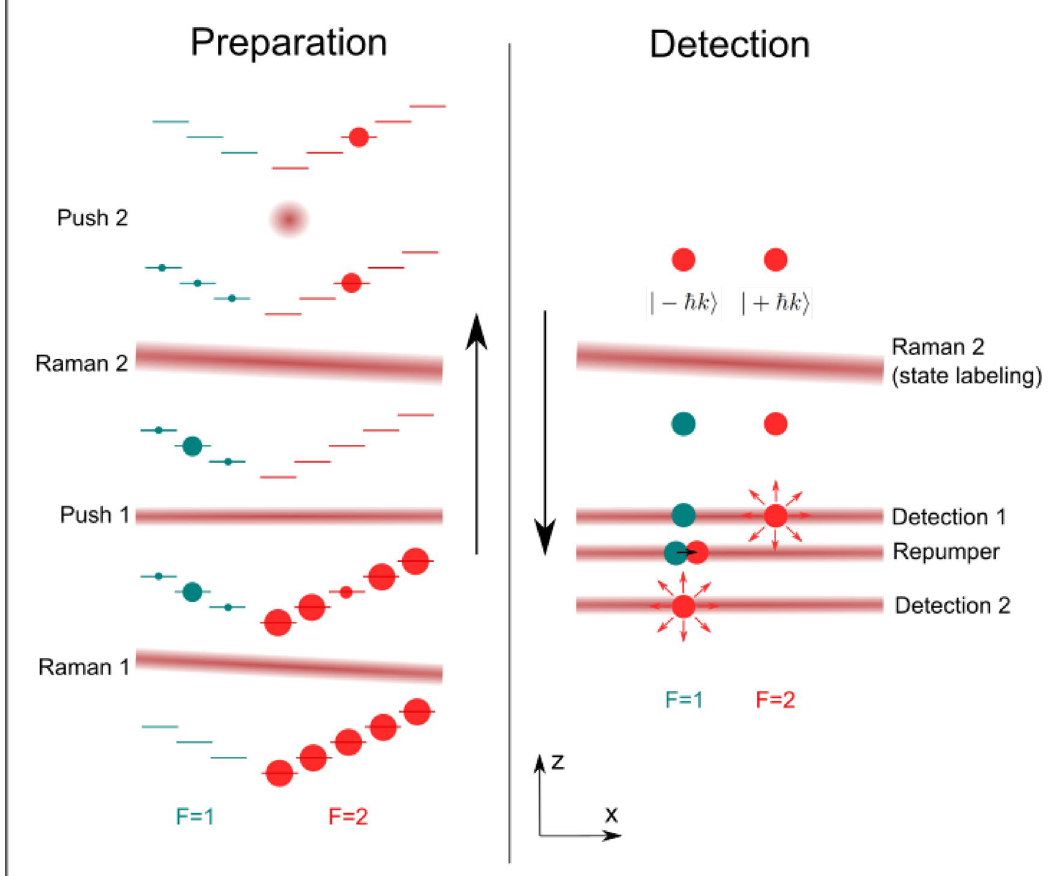
Figure 4. Atom preparation (left) and detection system (right). In the preparation, the atom cloud moving upward and initially containing atoms in all sublevels of F and pushing beams, which leaves the remaining atoms in the F velocity spread in the x direction. For the detection, atoms are leaving the interferometer in a superposition of two momentum states. The population in one of them is transferred to F Raman transition. State-selective fluorescence detection then allows to retrieve the output state and thus the interferometric